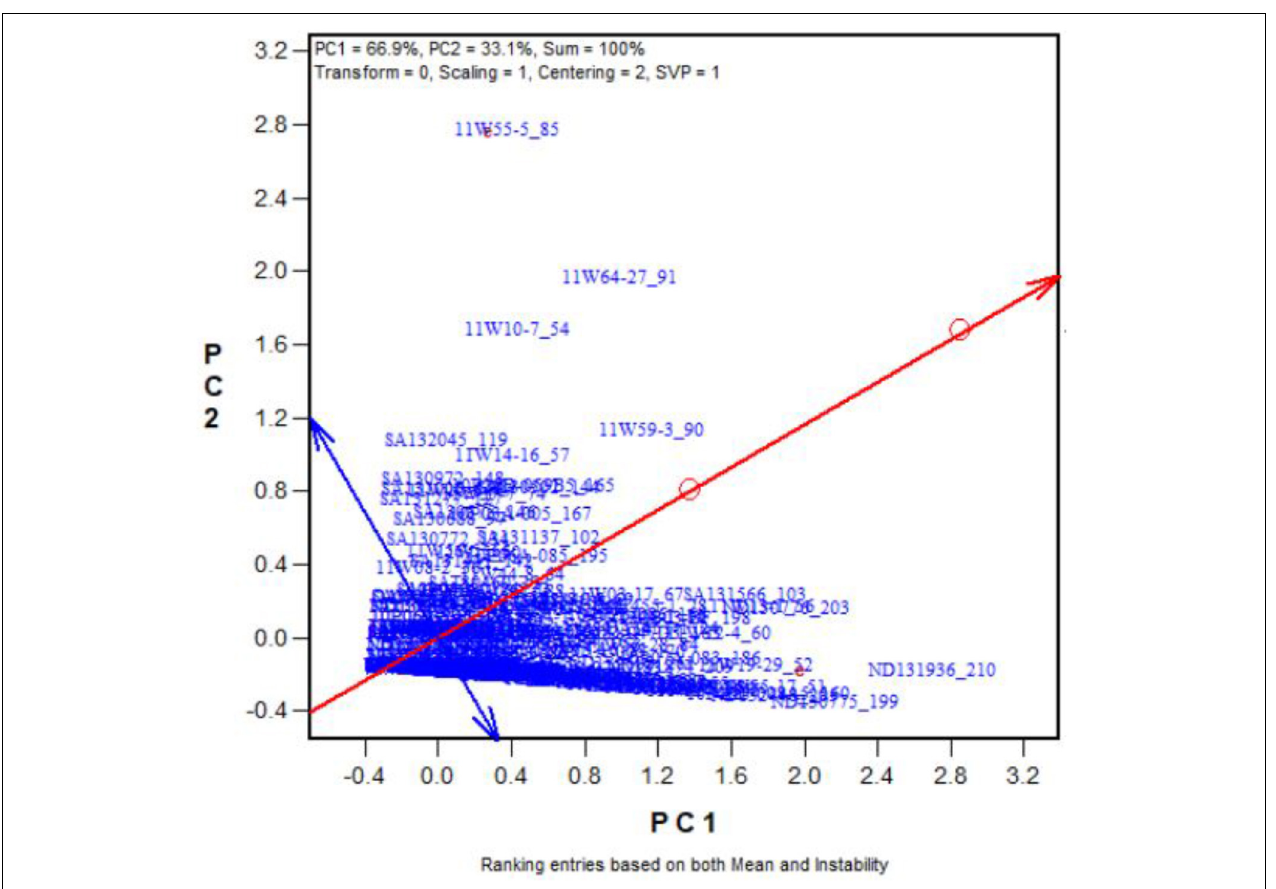
FIGURE 5 | Ranking the 262 genotypes based on their tolerance (in terms of number of grains produced) across the salt and alkali stresses.